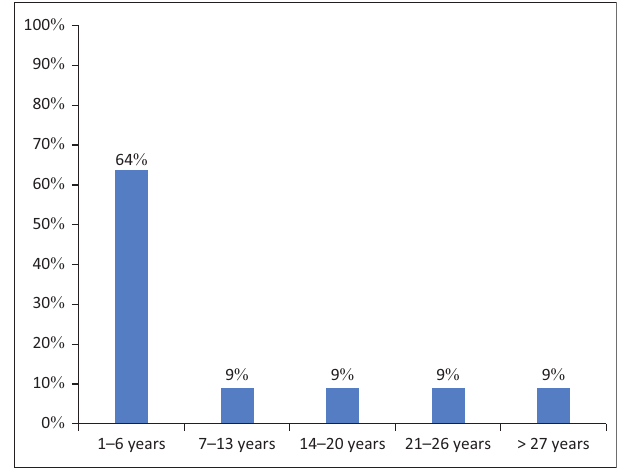
FIGURE 1: Paediatric oncologists work experience in years ( n =